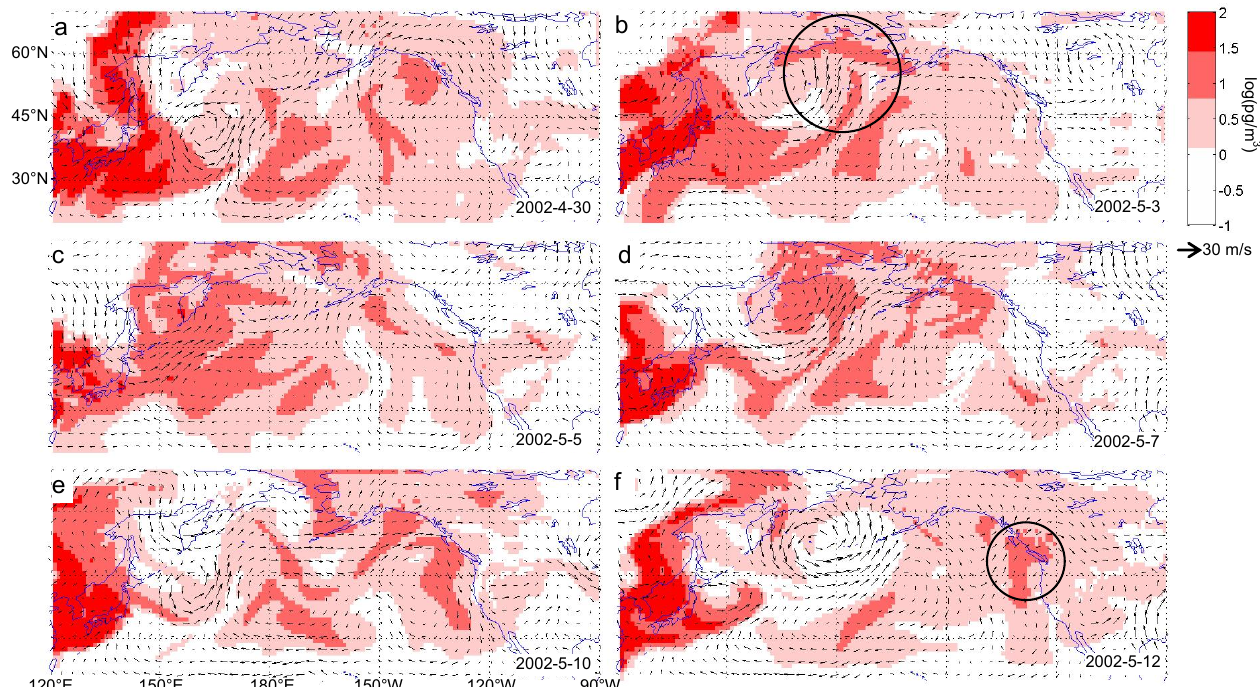
Figure 6. BaP concentration (background color) and wind field (arrows) at 1200 m during the Fig. 6. BaP concentration (background color) and wind field (arrows) at 1200m during the transport event on 12 May 2002; (a–f) show 30 transport event on 12 May 2002; a ‐ f show 30 April, 3 May, 5 May, 7 May, 10 May and 12 May, April, 3 May, 5 May, 7 May, 10 May and 12 May, respectively.